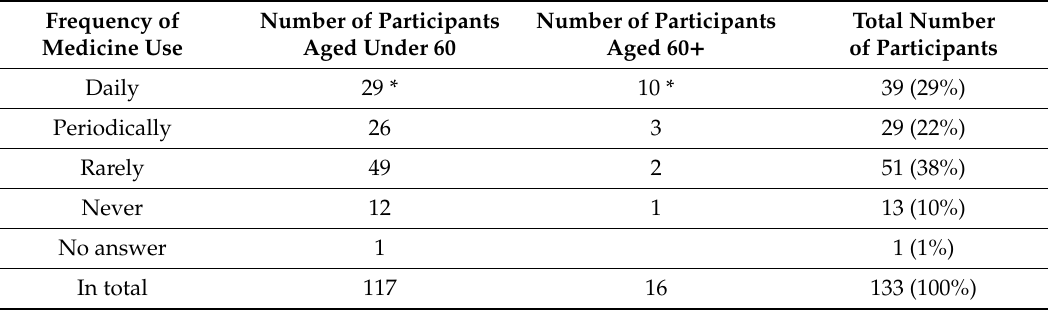
Table 2. Frequency of medicine use among the participants by